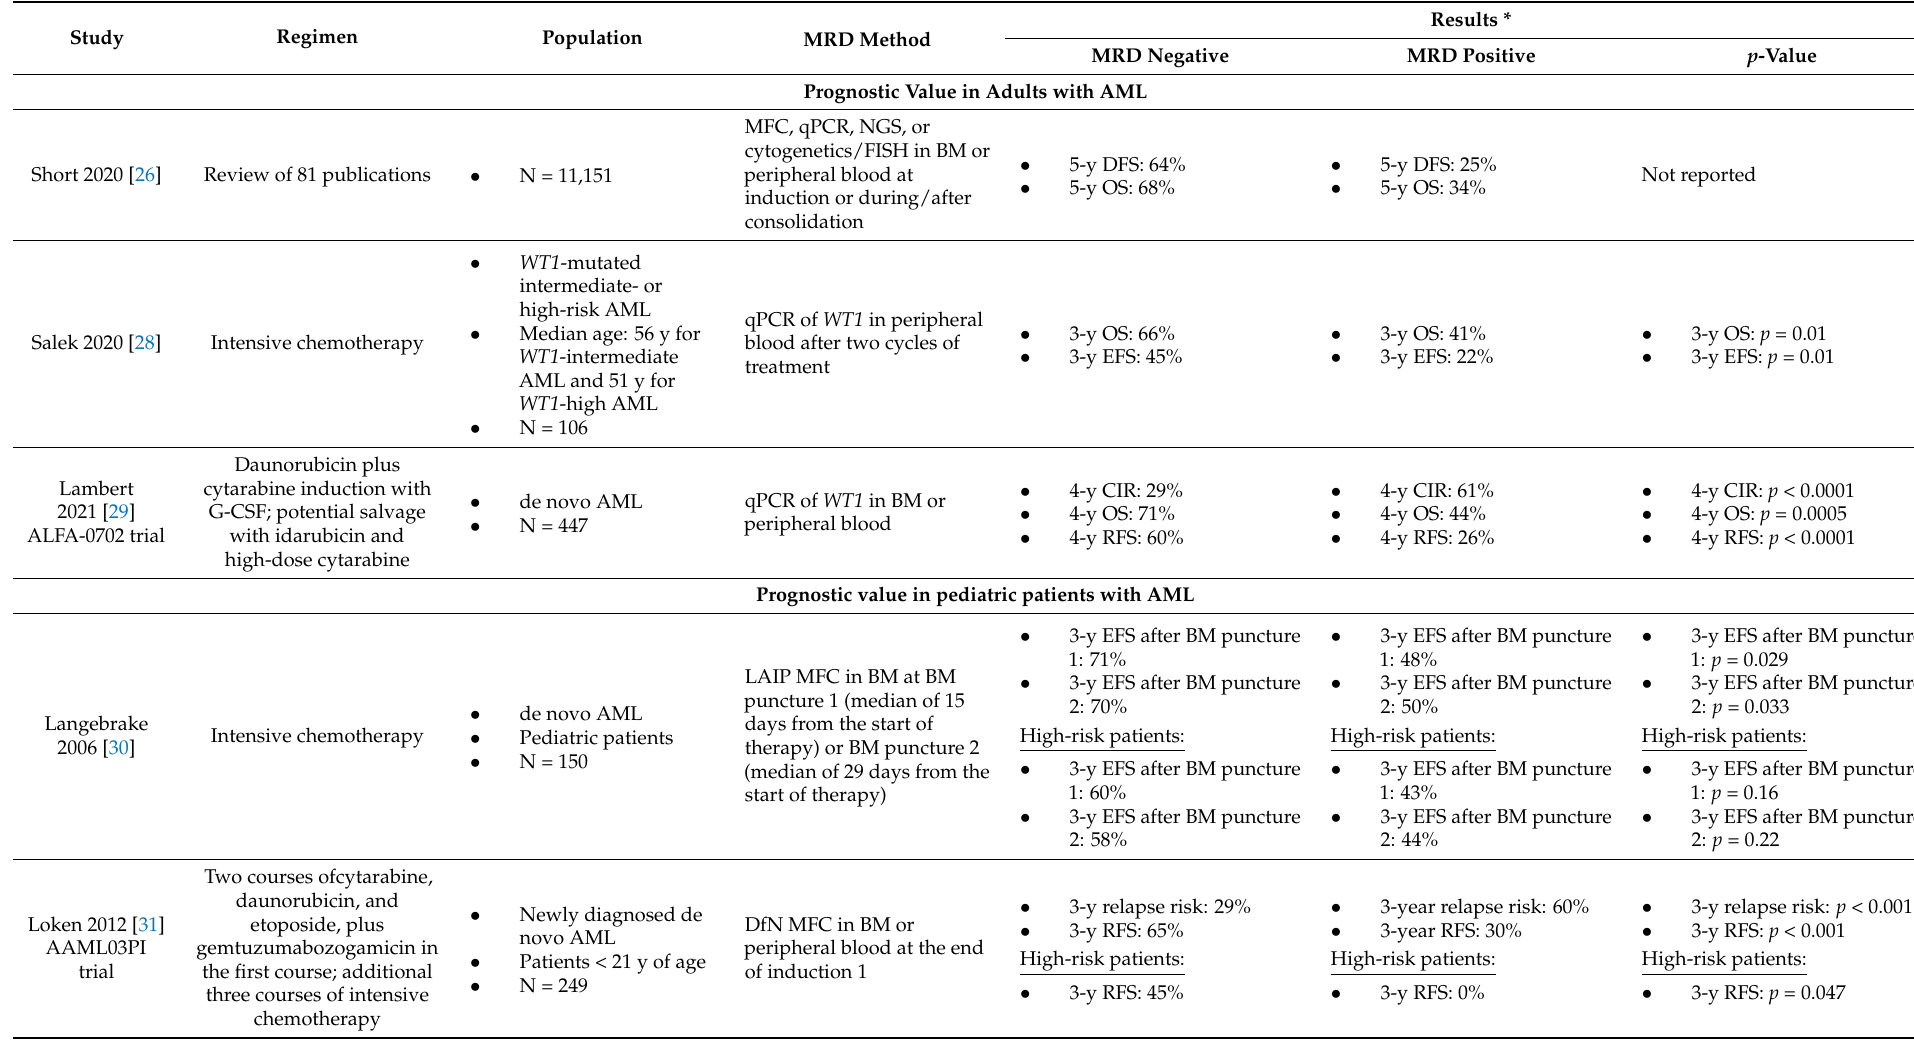
Table 2. Prognostic Value of MRD in